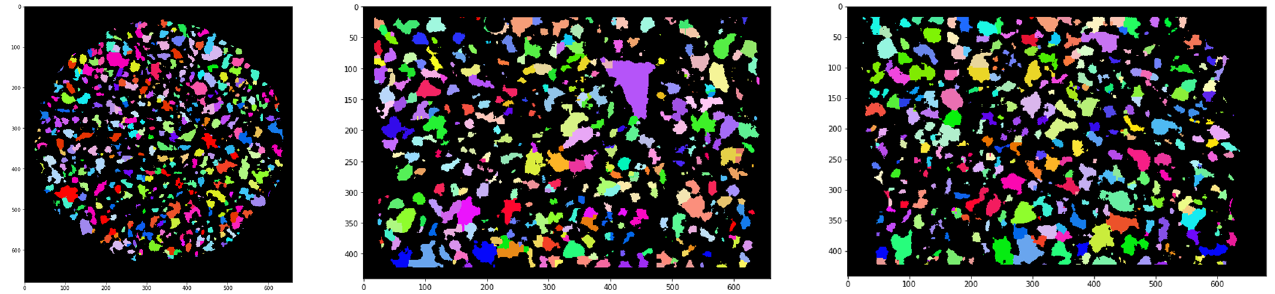
Figure 6. Orthogonal tomographic cross-sections of the pores in the spherical approximation. Each pore is colored in a unique color.